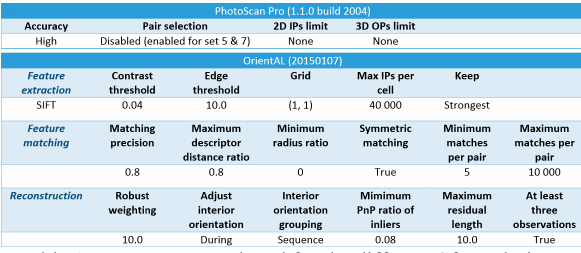
Table 1. Parameters employed for the different SfM solutions.